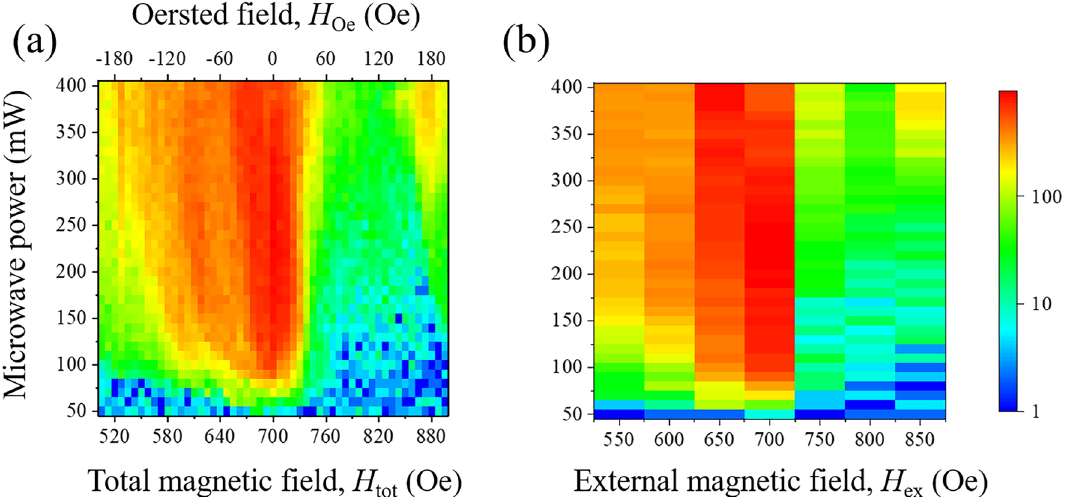
Figure 3. Threshold characteristics of parallel parametric pumping, i.e., BLS intensity as a function of the microwave power with a fixed frequency ( f mw = 11.2 GHz) and the magnetic field: (a) the Oersted field and total field are controlled by the dc electric current; (b) an external static field is applied in a range of 550 Oe ≤ H ≤ 850 Oe with a 50 Oe step. The color scale represents the BLS intensity of the spin wave with a frequency of f sw = 5.6 GHz.